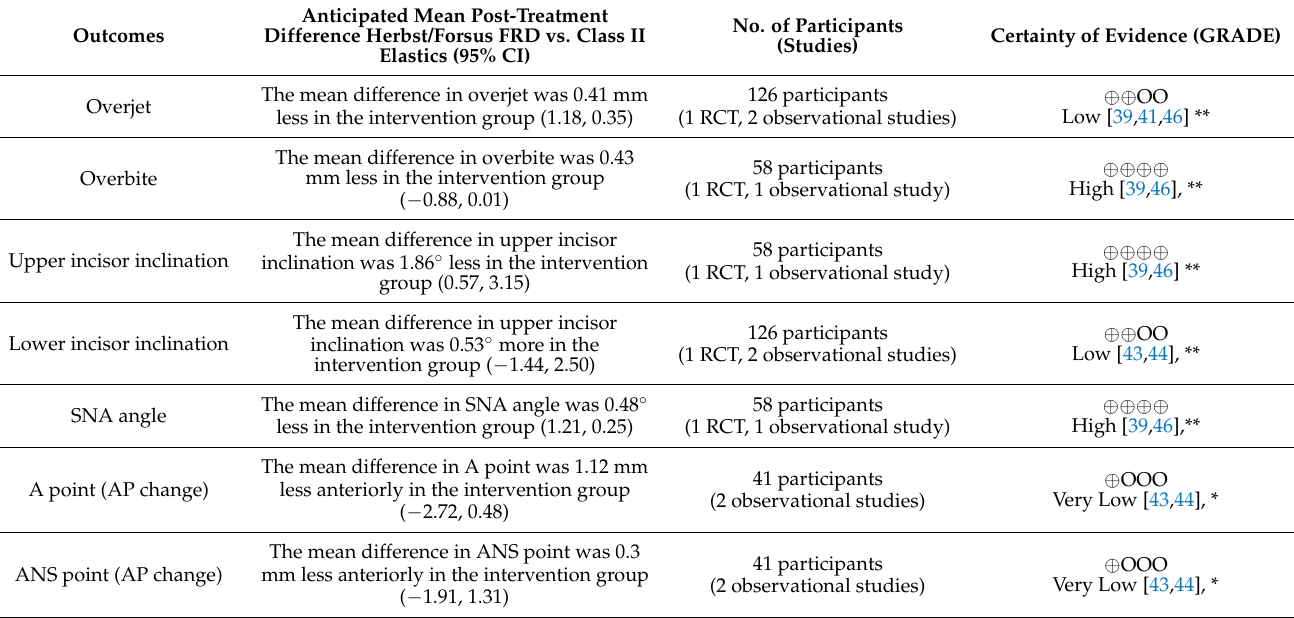
Table 4. GRADE summary of findings for all the